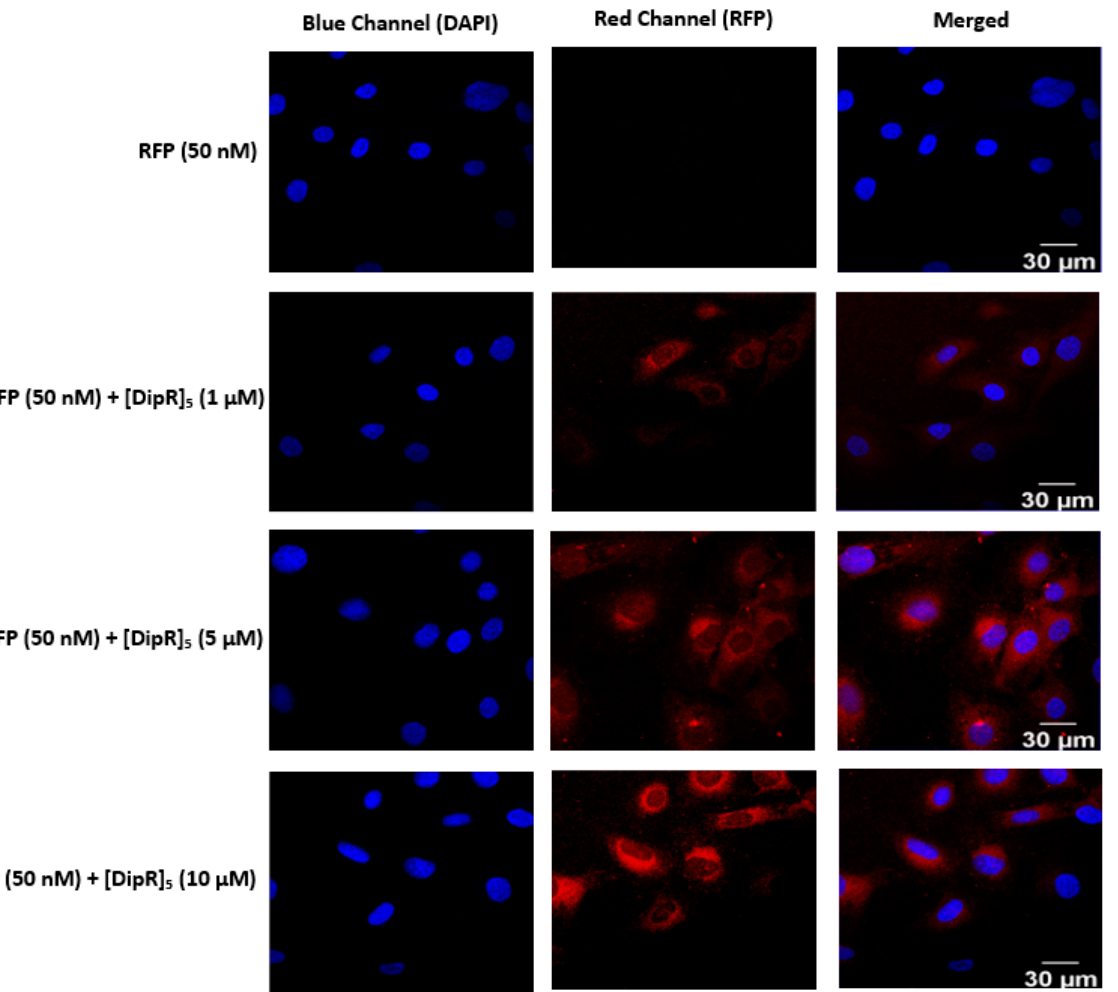
Figure 12. Confocal microscopy images of SK-OV-3 cells incubated with the RFP-[DipR] 5 mixture at a peptide concentration (1–10 µM) and RFP at (50 nM) for 3 h. The red and blue channels visualize RFP and DAPI, respectively.